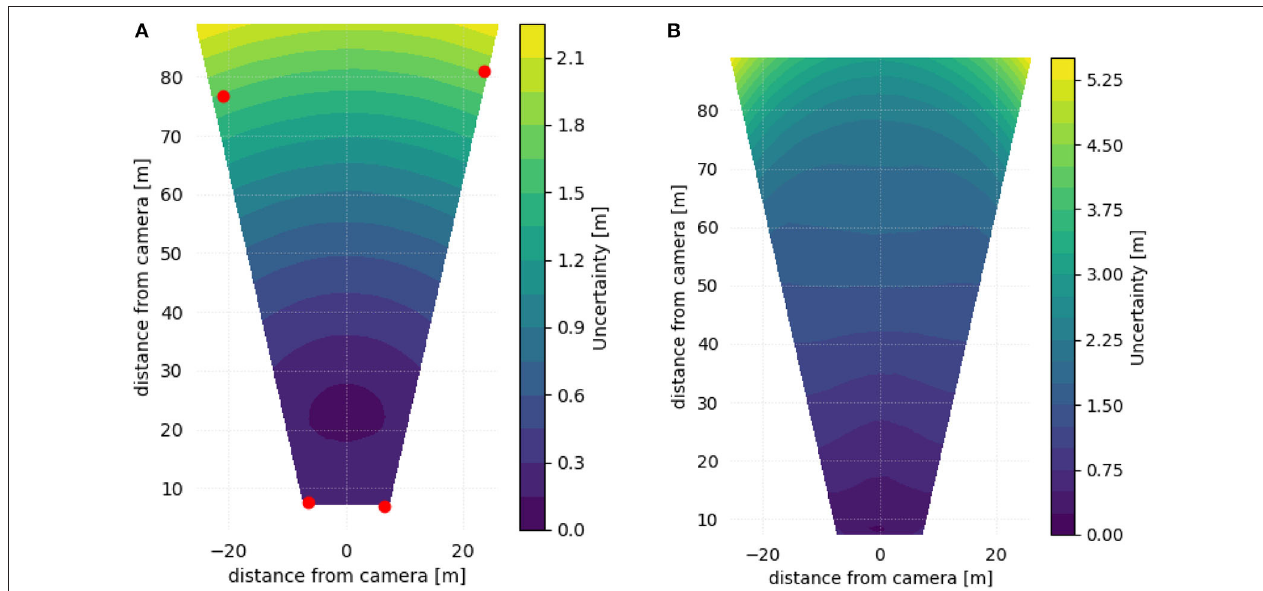
FIGURE 2 | Contours of the 95th percentile of spatial uncertainty estimated at each pixel footprint in an oblique view camera setup, without correcting the images for radial distortion. (A) Using 4 GCPs located near the corners of the FOV (red dots). (B) Using direct georeferencing.